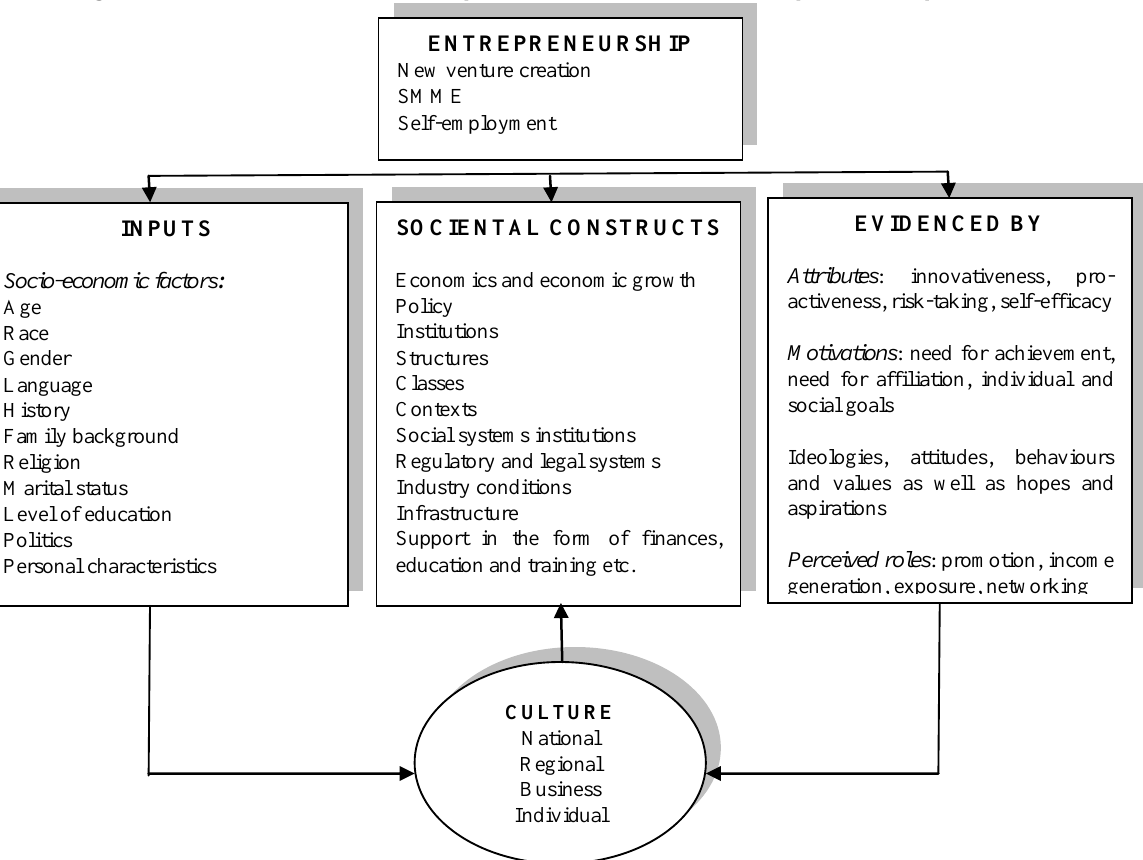
Figure 1: Model of the relationship between culture and